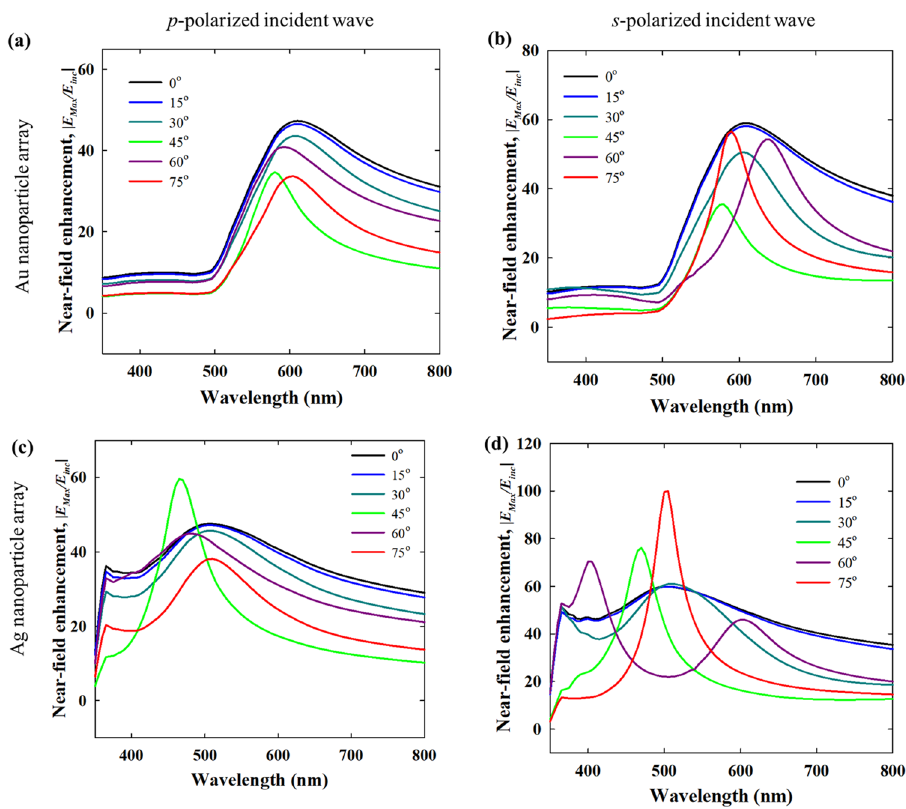
varying incident angle ( n = 1.5 for the denser medium, n = 1 for the lighter medium and interparticle gap: 1 nm). Legend: for each color from black to red, the solid lines represent near-field enhancement w.r.t. the incident field (without the nanoparticles and the Kretschmann